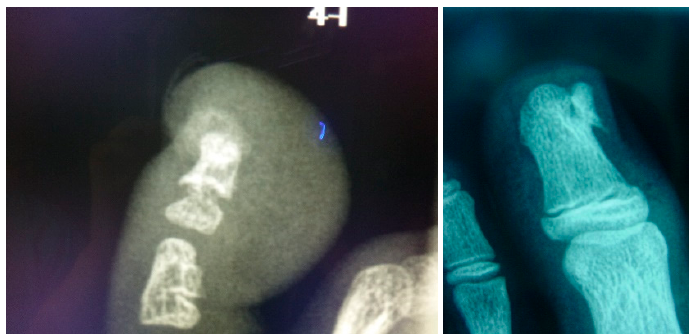
Figure 1. Pre-surgery treatment, clinical appearance and x-ray images for one of the selected cases.